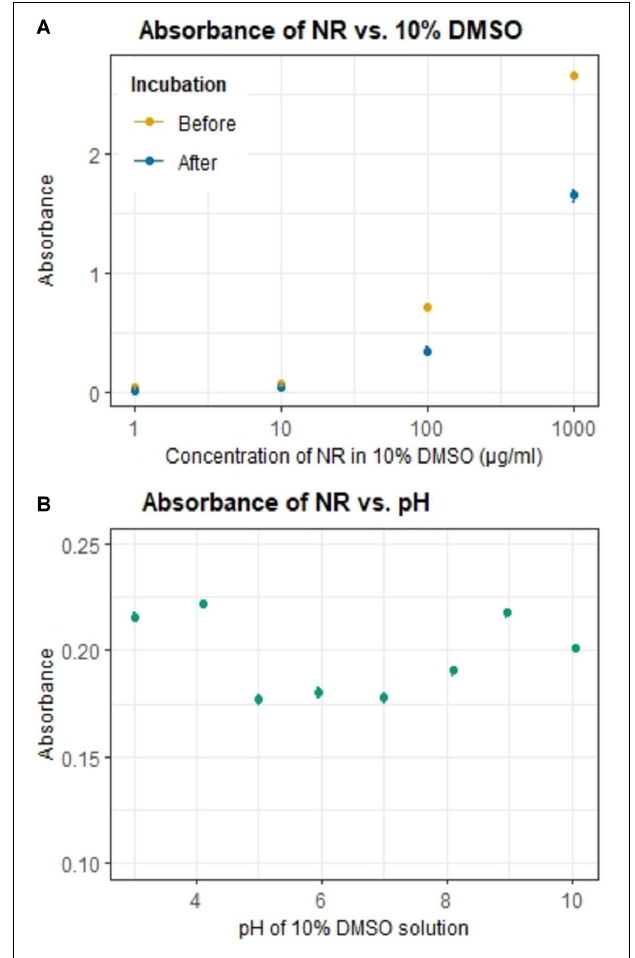
FIGURE 2 | Variation of the absorbance of NR (10 µ g/ml) by (A) its concentration in 10% DMSO before and after incubation (note that NR concentration is in logarithm scale), and (B) pH of the 10% DMSO